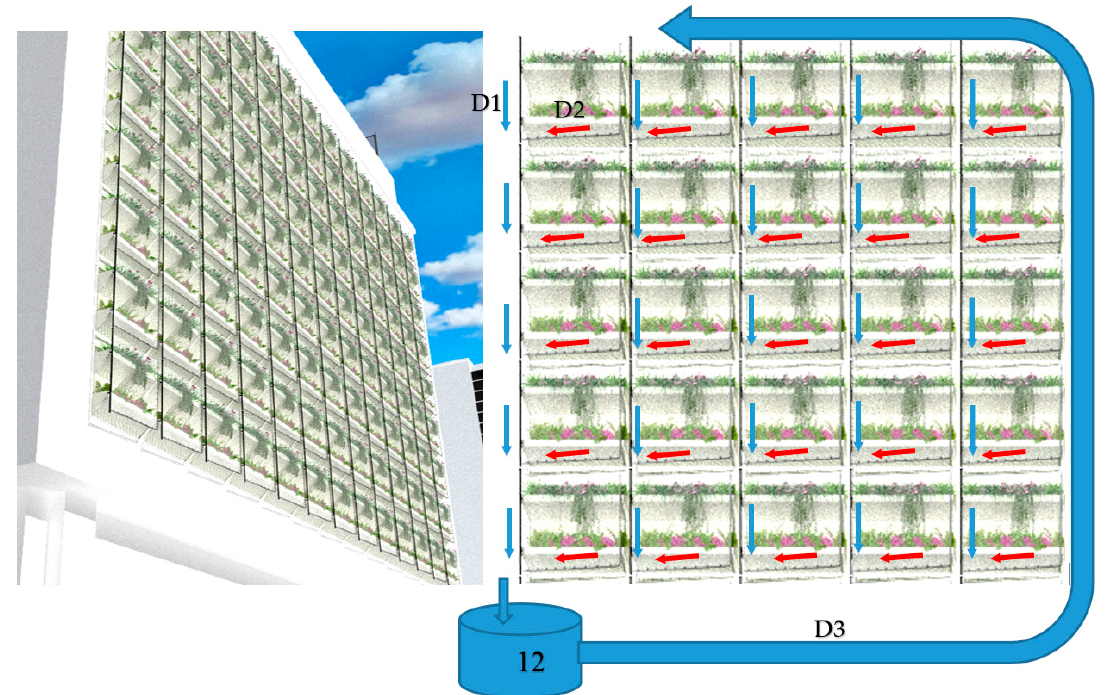
Figure 3. The installation of two novel living wall systems and the water droplets’ movement.